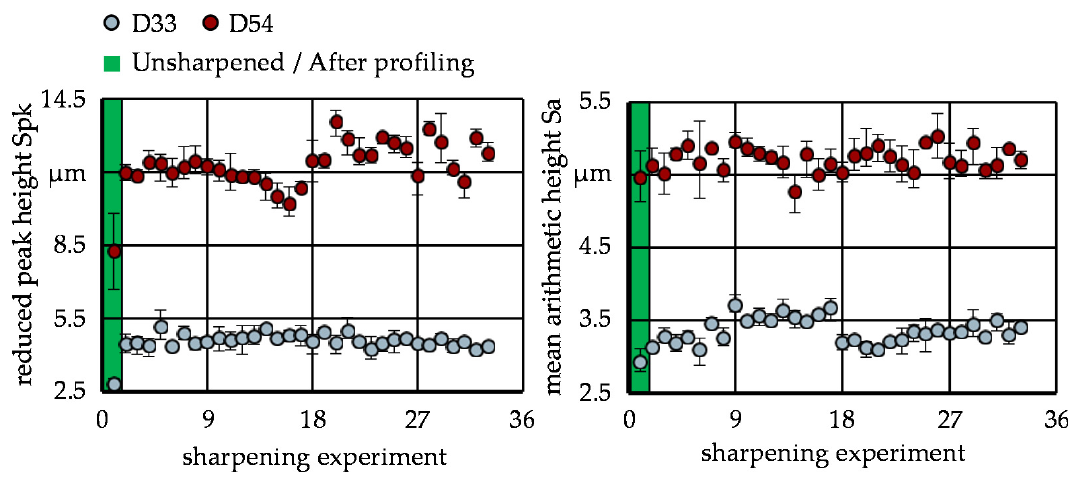
Figure 4. Topography characteristics of the sharpening experiments.